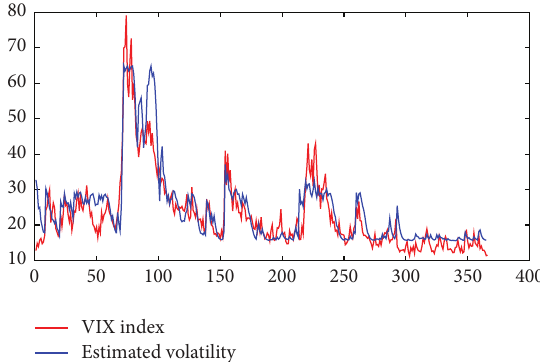
Figure 6: VIX index (red) versus estimated volatility (blue).